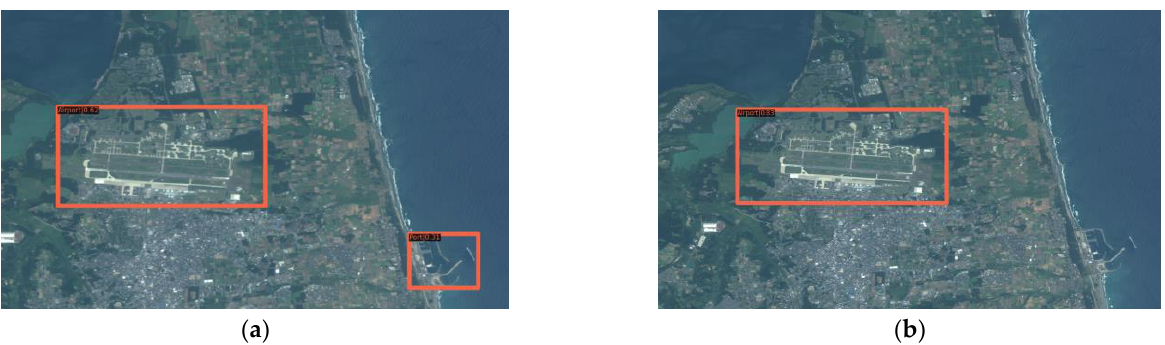
Figure 11. Multi-target prediction missed standard comparison: ( a ) Swin-HSTPS ’ s multi-type target prediction results; ( b ) Swin Transformer ’ s multi-type target prediction results (not marked in the lower right corner).